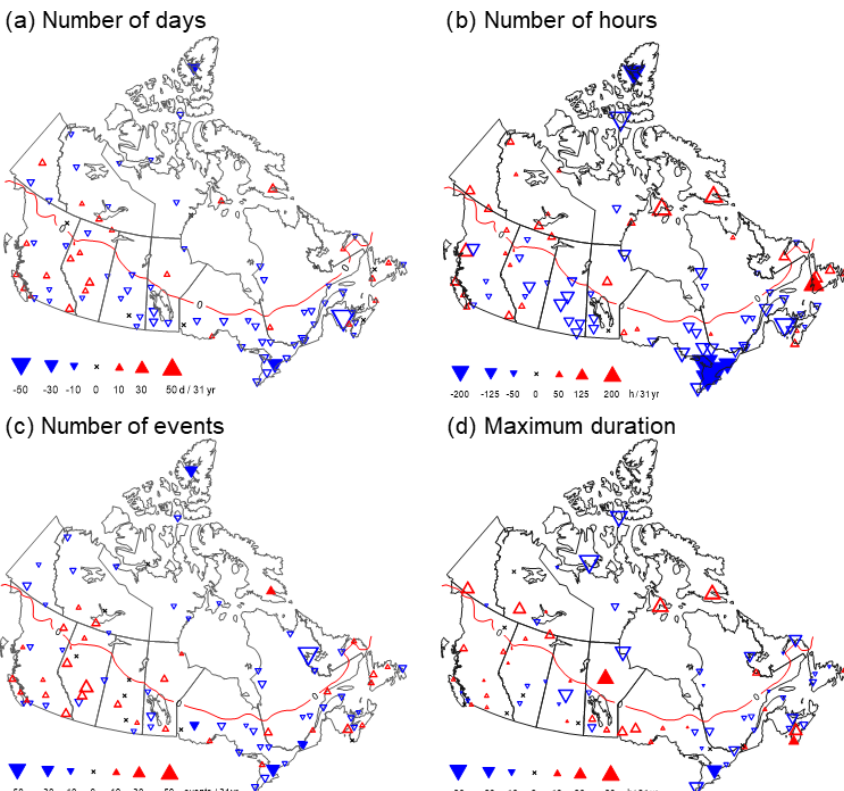
Figure 5. Trends in near-0 ◦ C ( − 2 ≤ T ≤ 2 ◦ C) conditions over the 1981–2011 period: (a) annual average number of days, (b) annual average hours, (c) annual number of events, and (d) annual maximum duration. A solid triangle indicates statistical significance at the 5% level. The red line indicates the annual average 0 ◦ C surface temperature computed from the 1981 to 2010 climate normals (ECCC,